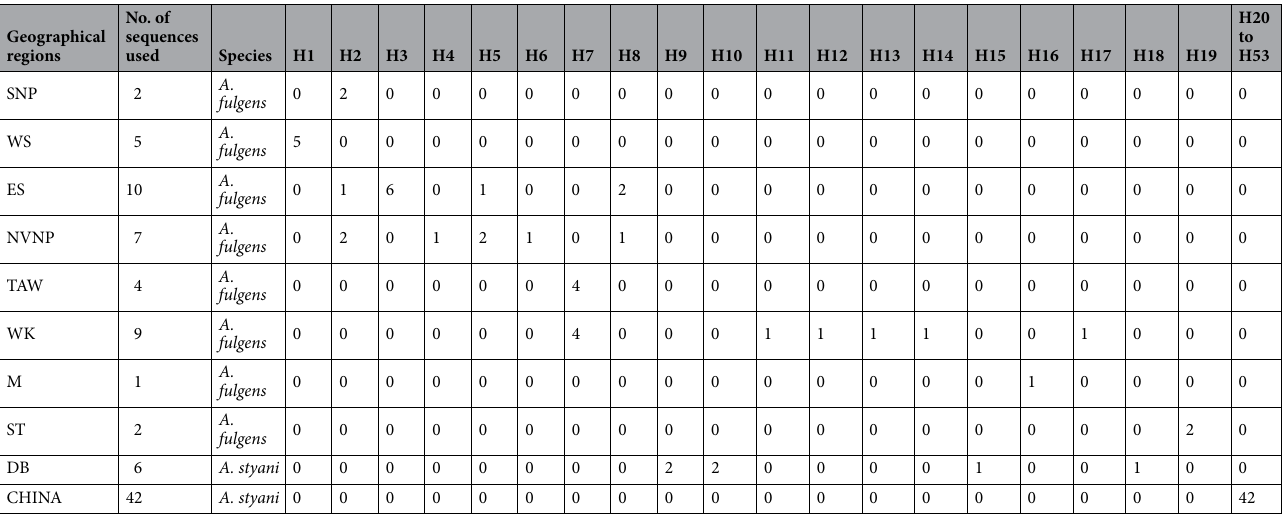
Table 1. Observed haplotypes in red panda across its range. SNP Singhalila NP, WS west Sikkim, ES east Sikkim, NVNP Neora valley NP, TAW Tawang, WK west Kameng, M Menchuka, DB Dibang valley, ST south Tibet, China.